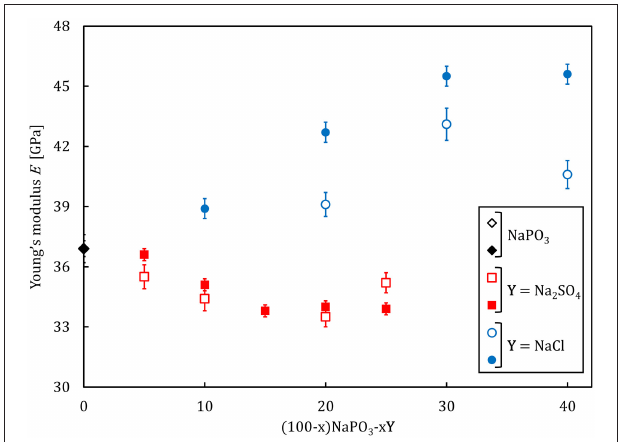
FIGURE 6 | Compositional dependence of the average effective mass, gauged T g · c − 2 a by , for (100–x)NaPO 3 -x Y (with Y = Na 2 SO 4 , NaCl) (cid:16) (cid:17)